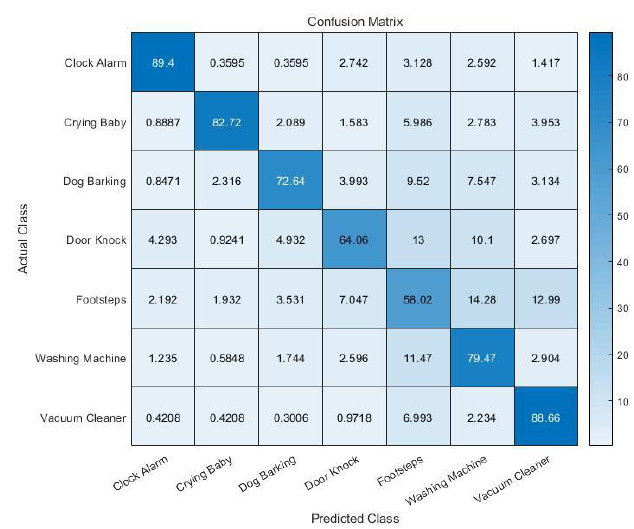
Figure 19. Five-fold cross-validation accuracy (MFCC + zero-crossing rate).